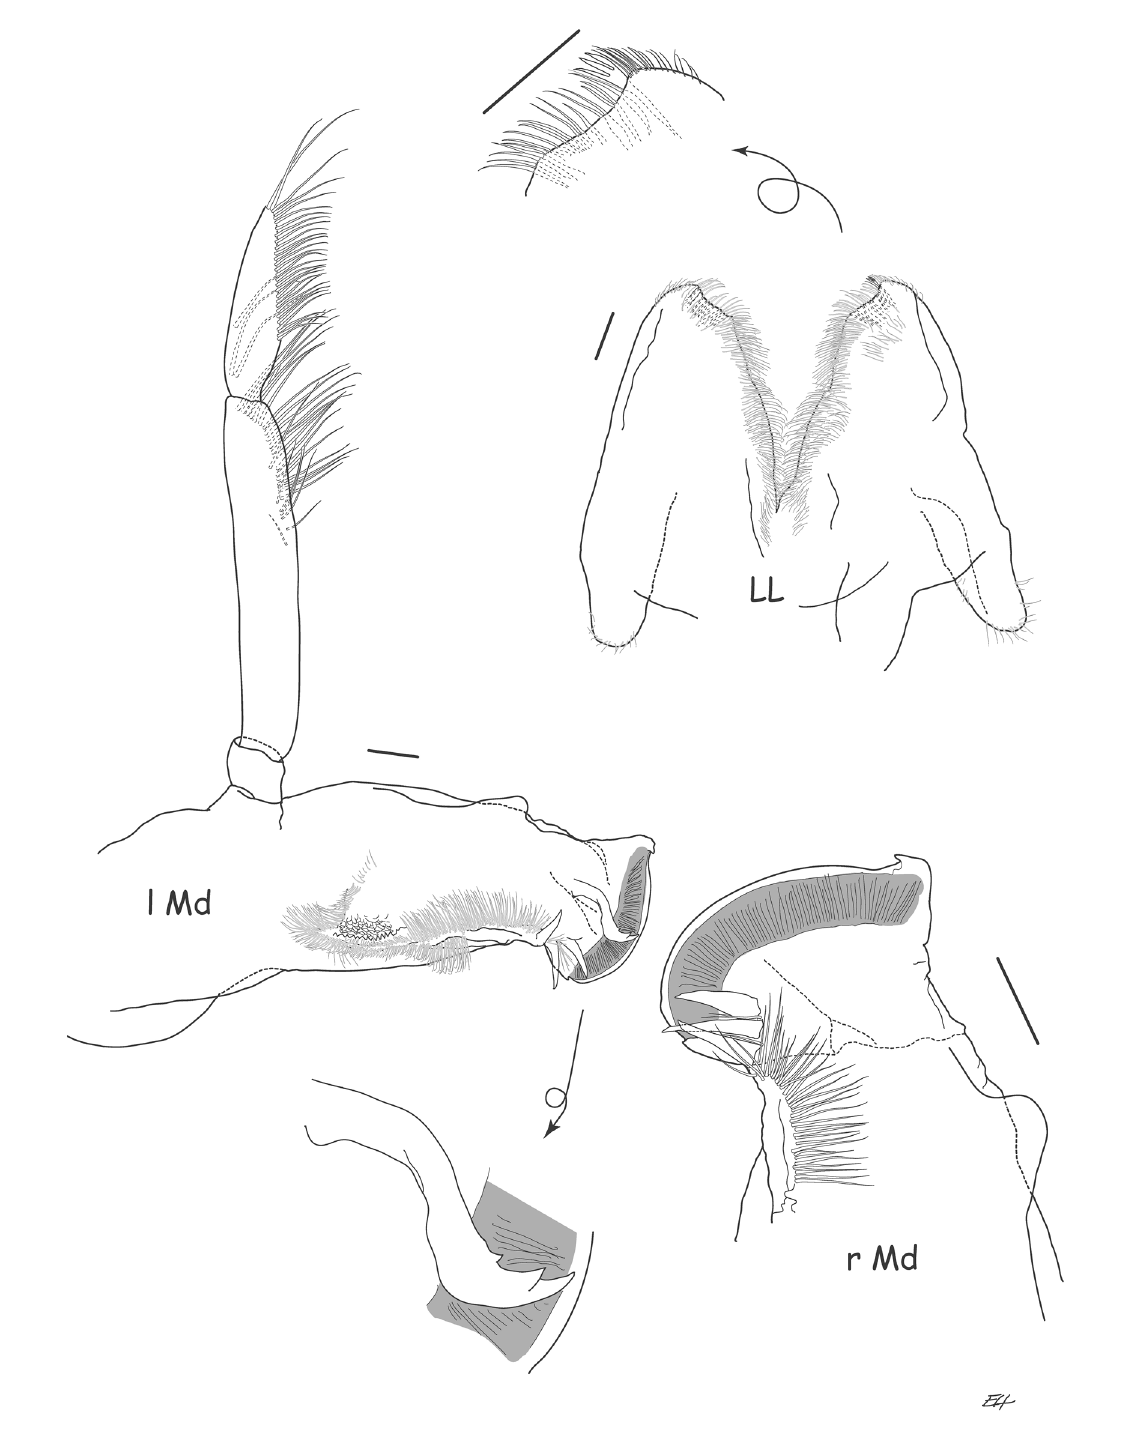
Fig. 20. Abyssorchomene scotianensis (Andres, 1983), ♀, 12 mm (CMNC 2022-0005). Scale bars = 0.1